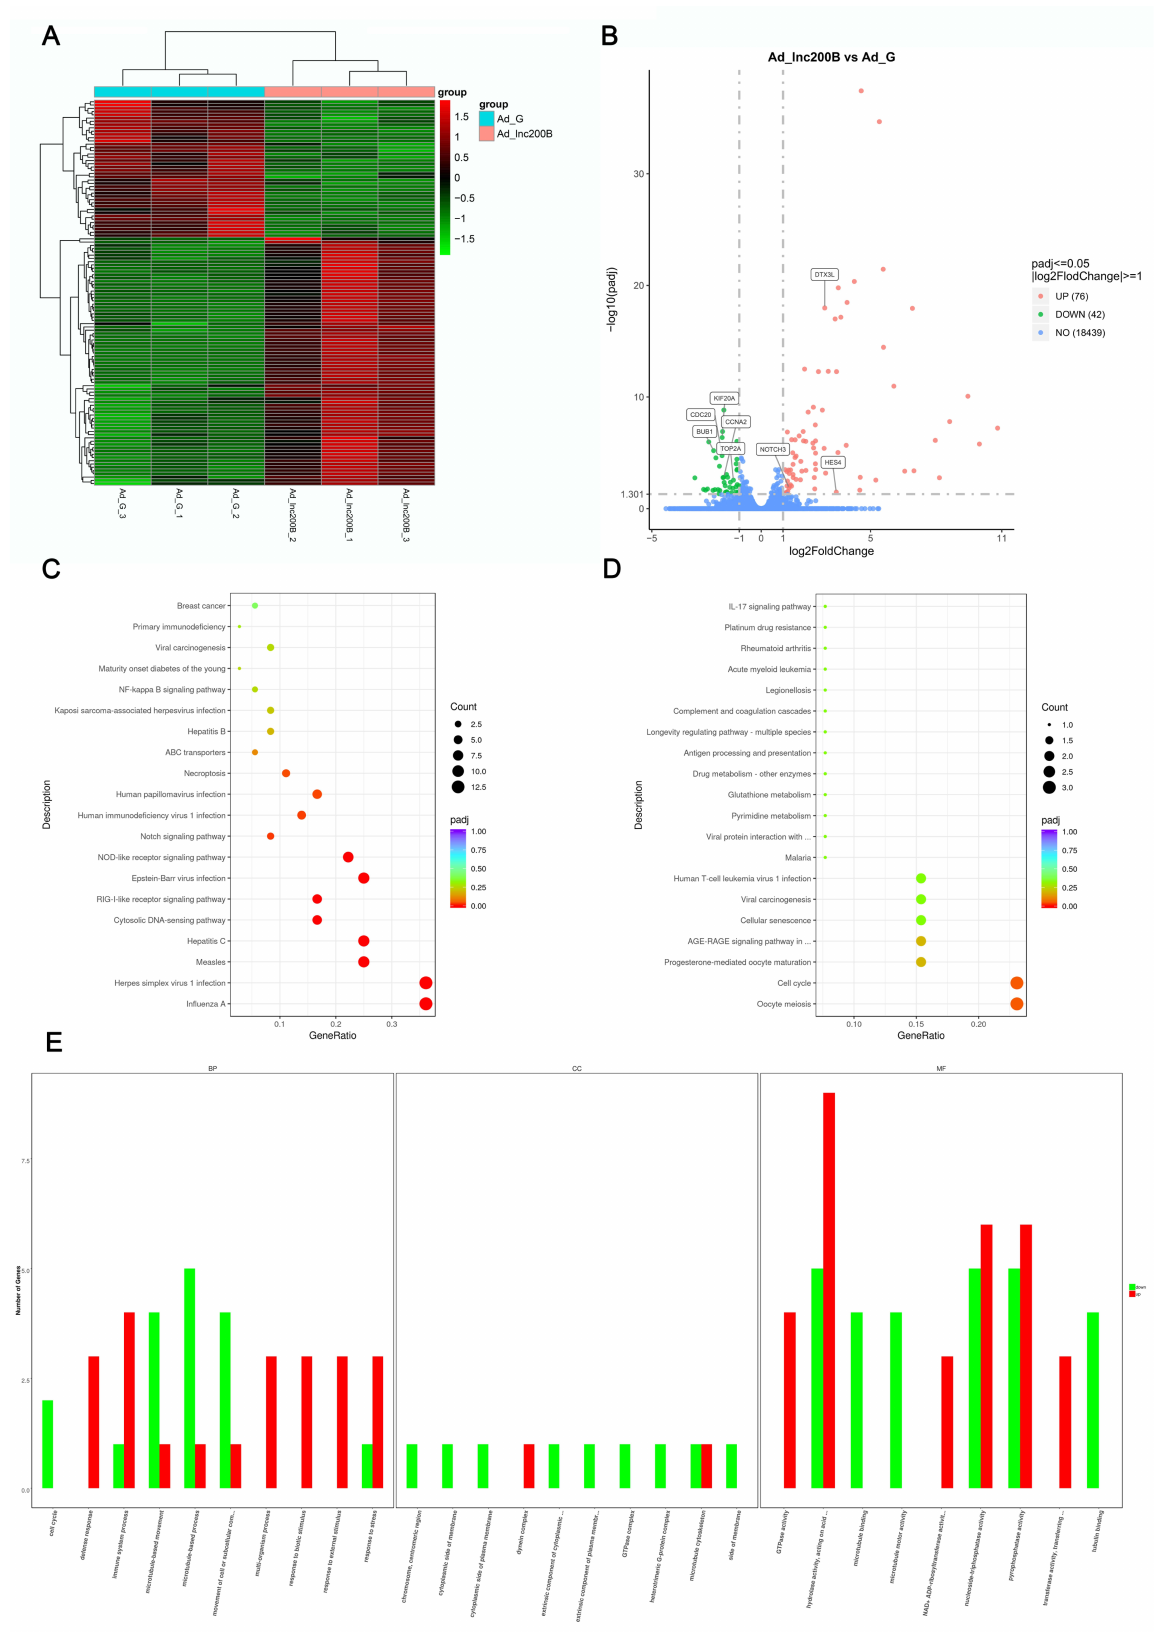
Figure 1. DEGs analysis and its functions annotation after lncFAM200B overexpression. ( A ) Clustering map of DEGs. ( B ) Volcanic map of DEGs. The up-regulation genes of the Notch signaling